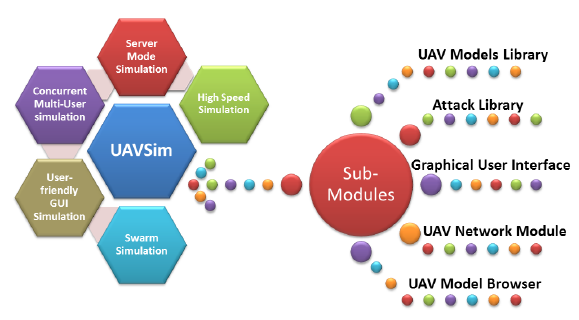
Figure 1. UAVSim: Modes of operations and various components in C++ [22]. Figure 1 shows the design of UAVSim in the right half. The left half shows various modes of